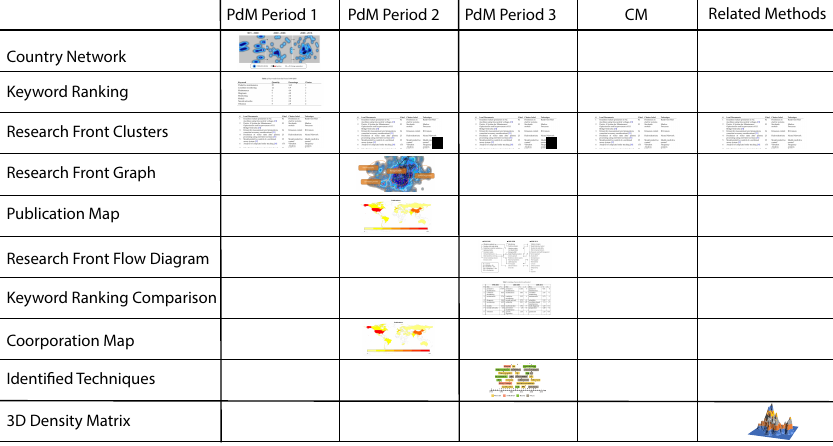
Figure 8. Visualizations in each